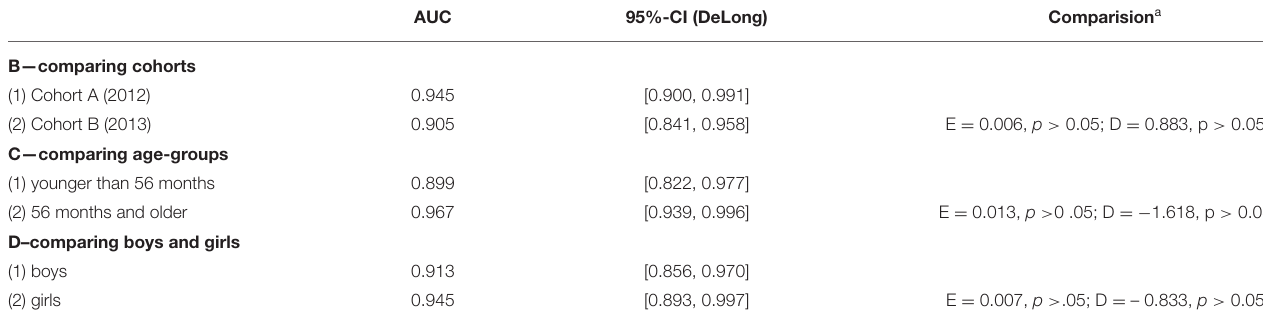
TABLE 2 | Tests for unpaired ROC